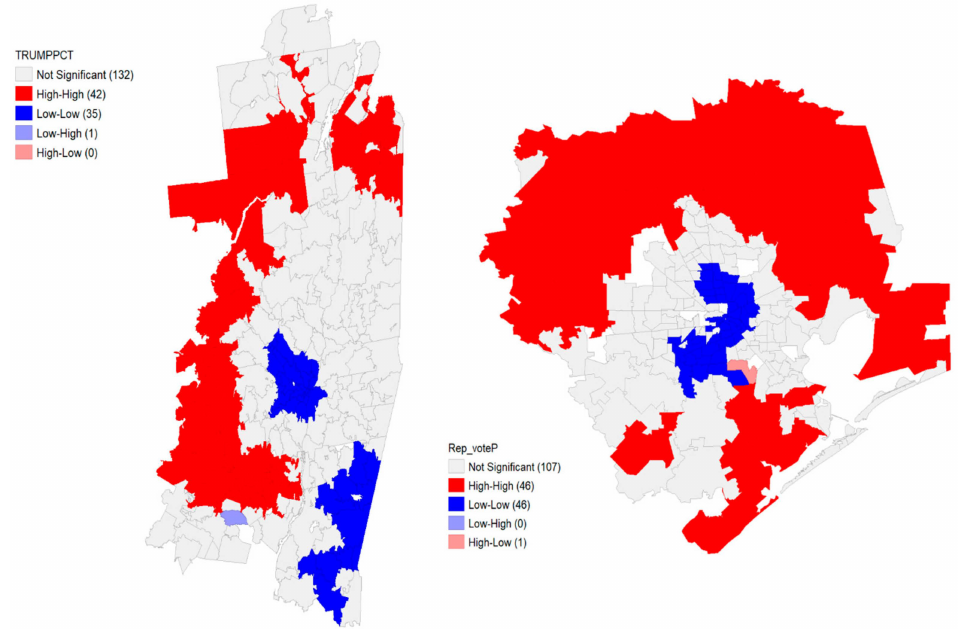
Figure 3. Local Moran’s I, showing clusters of Republican voters based on